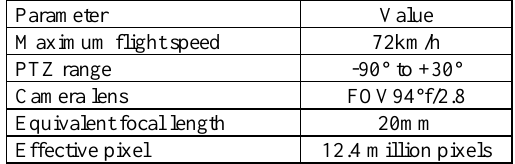
Table 1 . Detailed parameters of UAV.